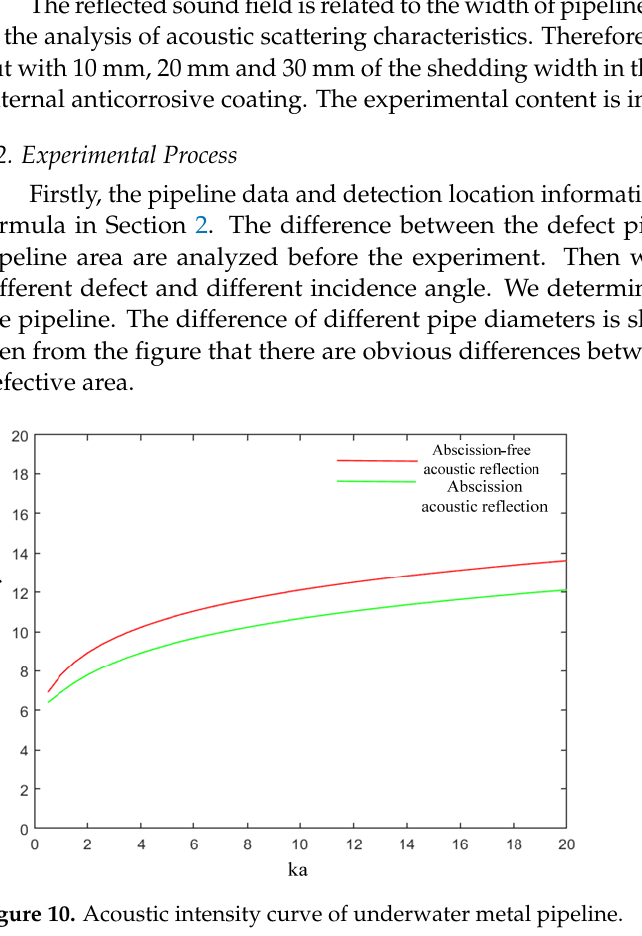
Figure 10. Acoustic intensity curve of underwater metal pipeline.